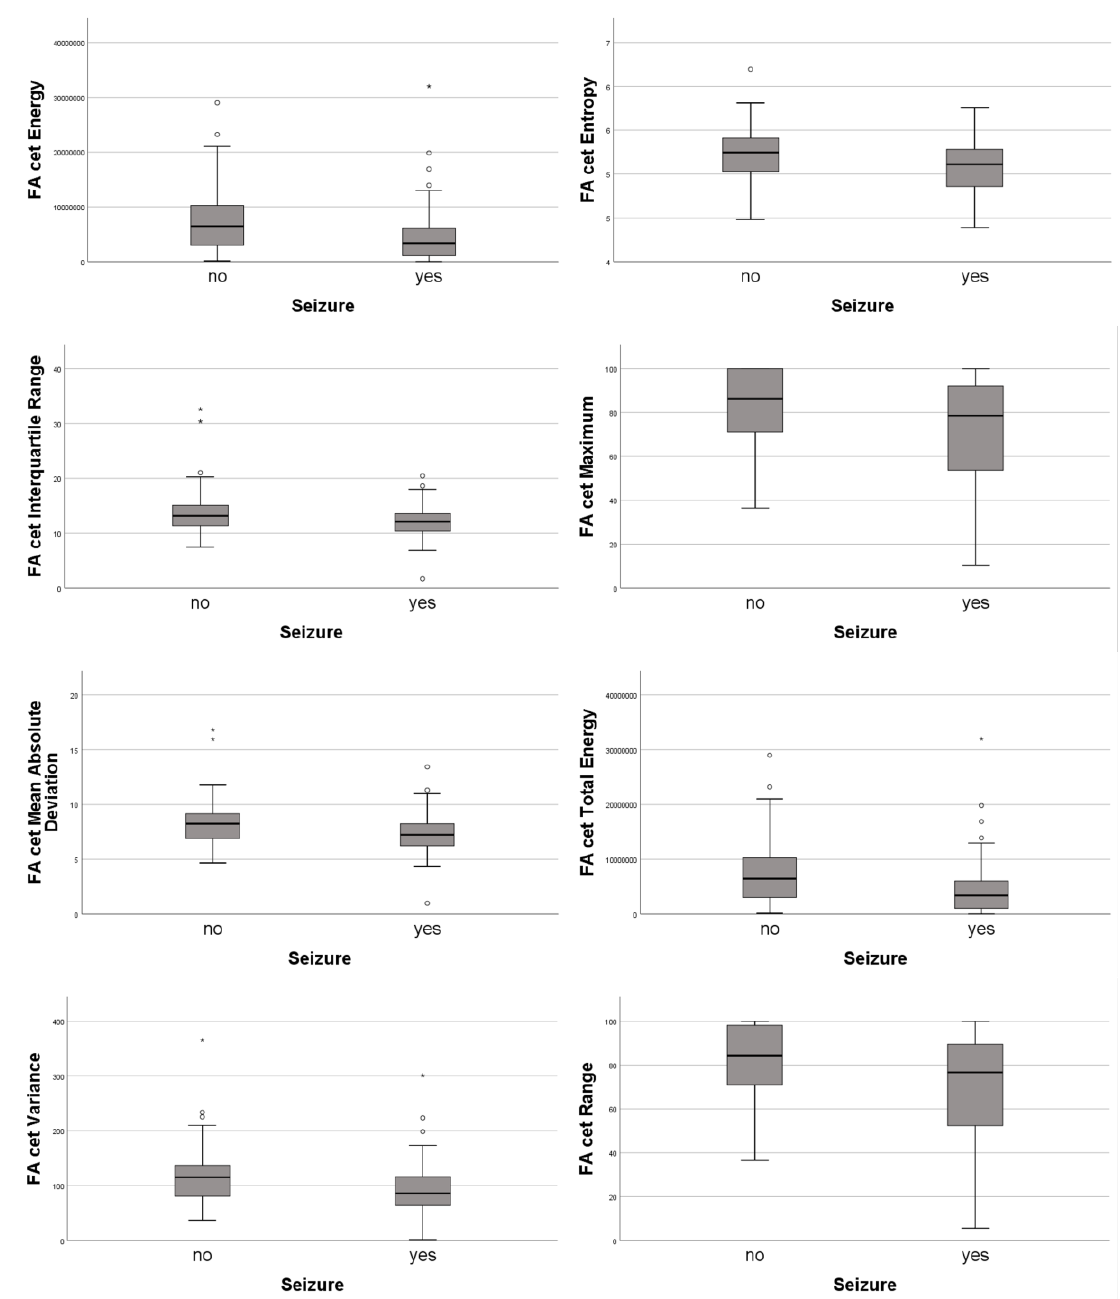
Figure 3. Boxplots for histogram analyses.